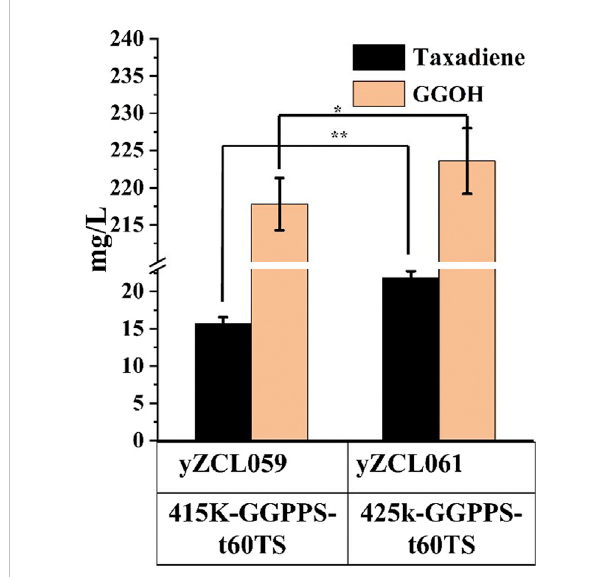
The effect of overexpression of fusion protein GGPPS-t60TS on the titers of taxadiene and GGOH. 415K incited single-copy plasmid, 425K incited multi-copy plasmid. The error bars represent the means ± SD from three biological replicates. **p < 0.01, *p < 0.05, student ’ s t -test.